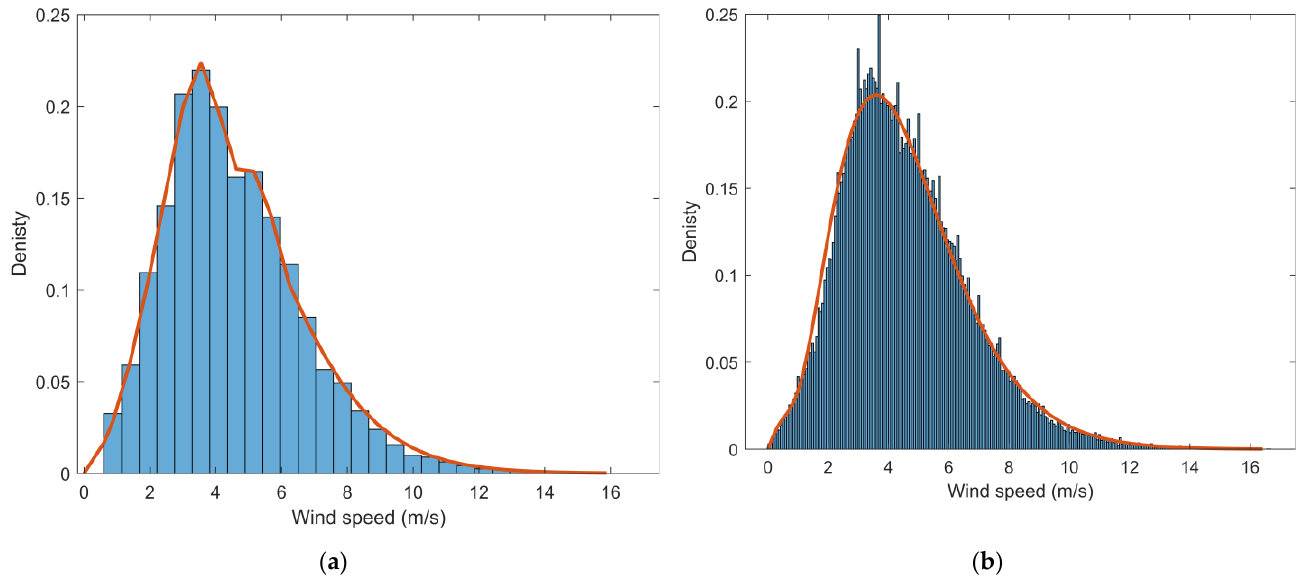
Figure 4. Fitting wind data of Site 2 to f mix using MOPSO: ( a ) 30 equal wind speed spacings; ( b ) variable wind speed